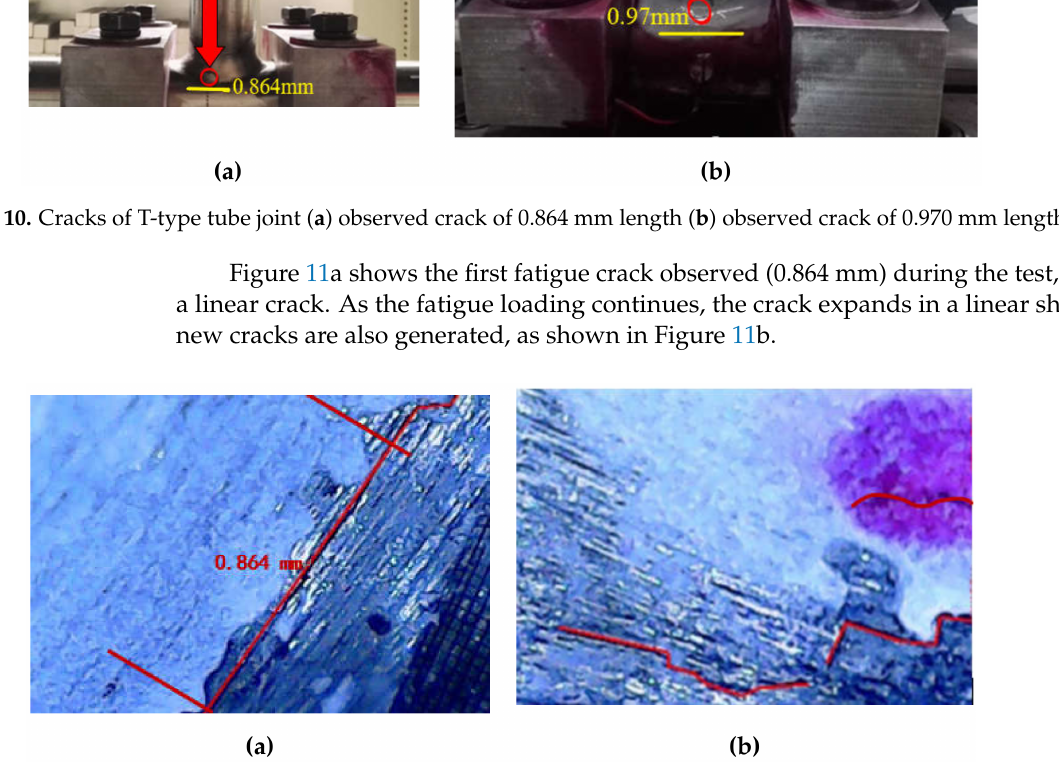
Figure 11. Microscopic observation of fatigue crack in T-type tube joint ( a ) observed crack of 0.864 mm length ( b ) cracks initiated at edges of the base